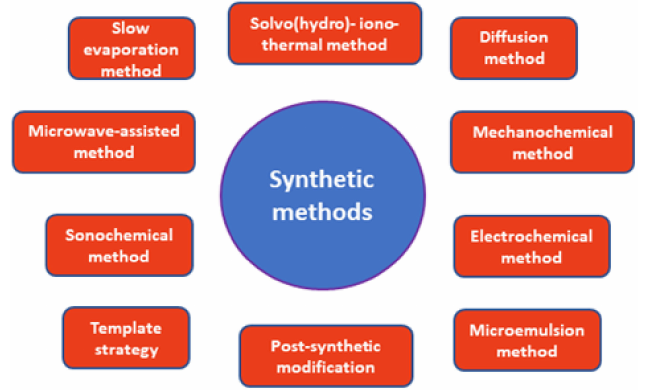
Figure 1. Synthetic methods used to obtain